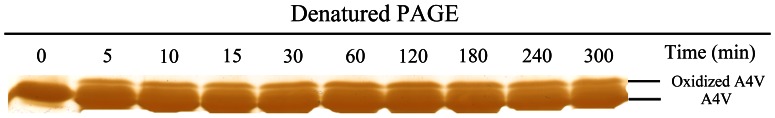
Cu2+-induced oxidation of A4V at various time points.13.5% SDS-PAGE of A4V incubated with 200 µM Cu2+ in 20 mM Tris-HCl buffer (pH 7.4) up to 5 h. Oxidized A4V (upper shifted band) was clearly observed when A4V was incubated with 200 µM Cu2+ for 5–300 min. The incubation times (from left to right) were 0, 5, 10, 15, 30, 60, 120, 180, 240, and 300 min, respectively. Gels were stained with silver. The final concentration of SOD1 was 10 µM.